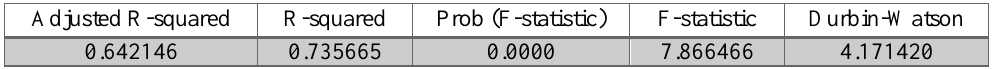
Table 4 . Other results of fixed effects- Model Number 1